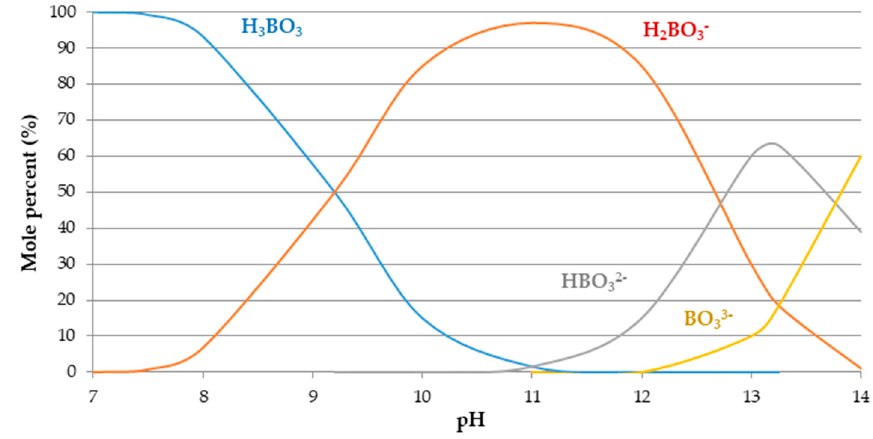
Figure 6. Boron speciation at different pH of aqueous solution.